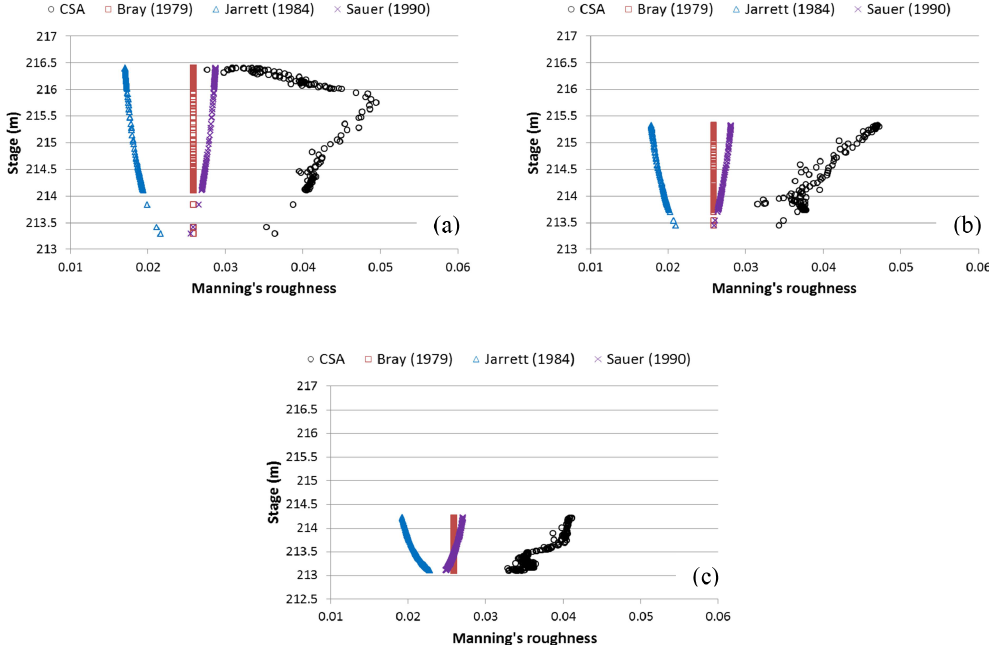
Figure 7. Comparison of the channel roughness coefficients estimated by various methods for the selected three events: (a) Event 1, (b) Event 2, and (c) Event 3. The black symbol represents the one based on the CSA implementation procedures and the red, blue, and violet symbols represent the Bray (1979), Jarrett (1984), and V. B. Sauer (US Geological Survey, written personal communication, 1990) methods, respectively.